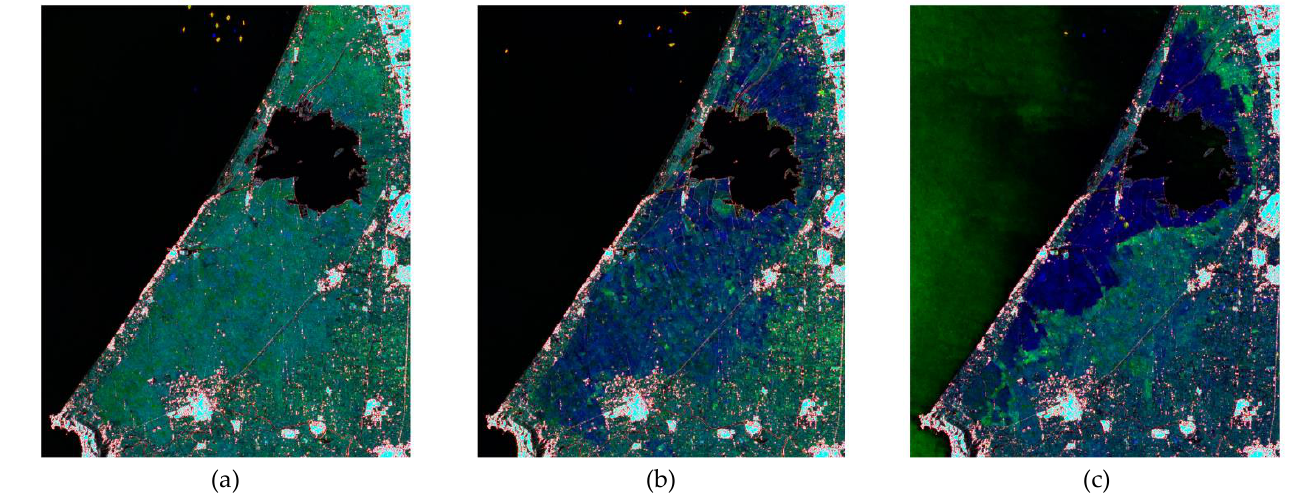
Figure 4. Evolution of the flooded area in the Albufera natural reserve (Spain). Pre-event image (blue band) acquired on 6 April 2017. Post-event images (green band) acquired on ( a ) 18 April 2017, ( b ) 4 August 2017 and ( c ) 14 December 2017 [180].